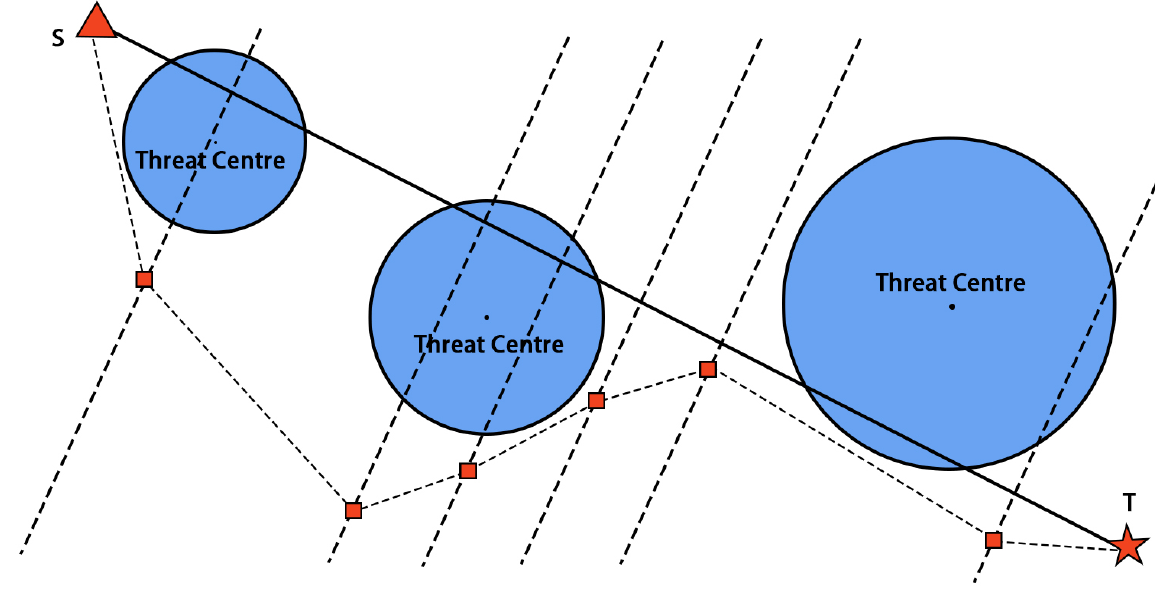
Figure 1. The schematic diagram for combat field modeling. The X and Y axles are the length and width of the horizontal battlefield. Note that all nodes are linked up to form a feasible path. During the flight, all threats are supposed to be